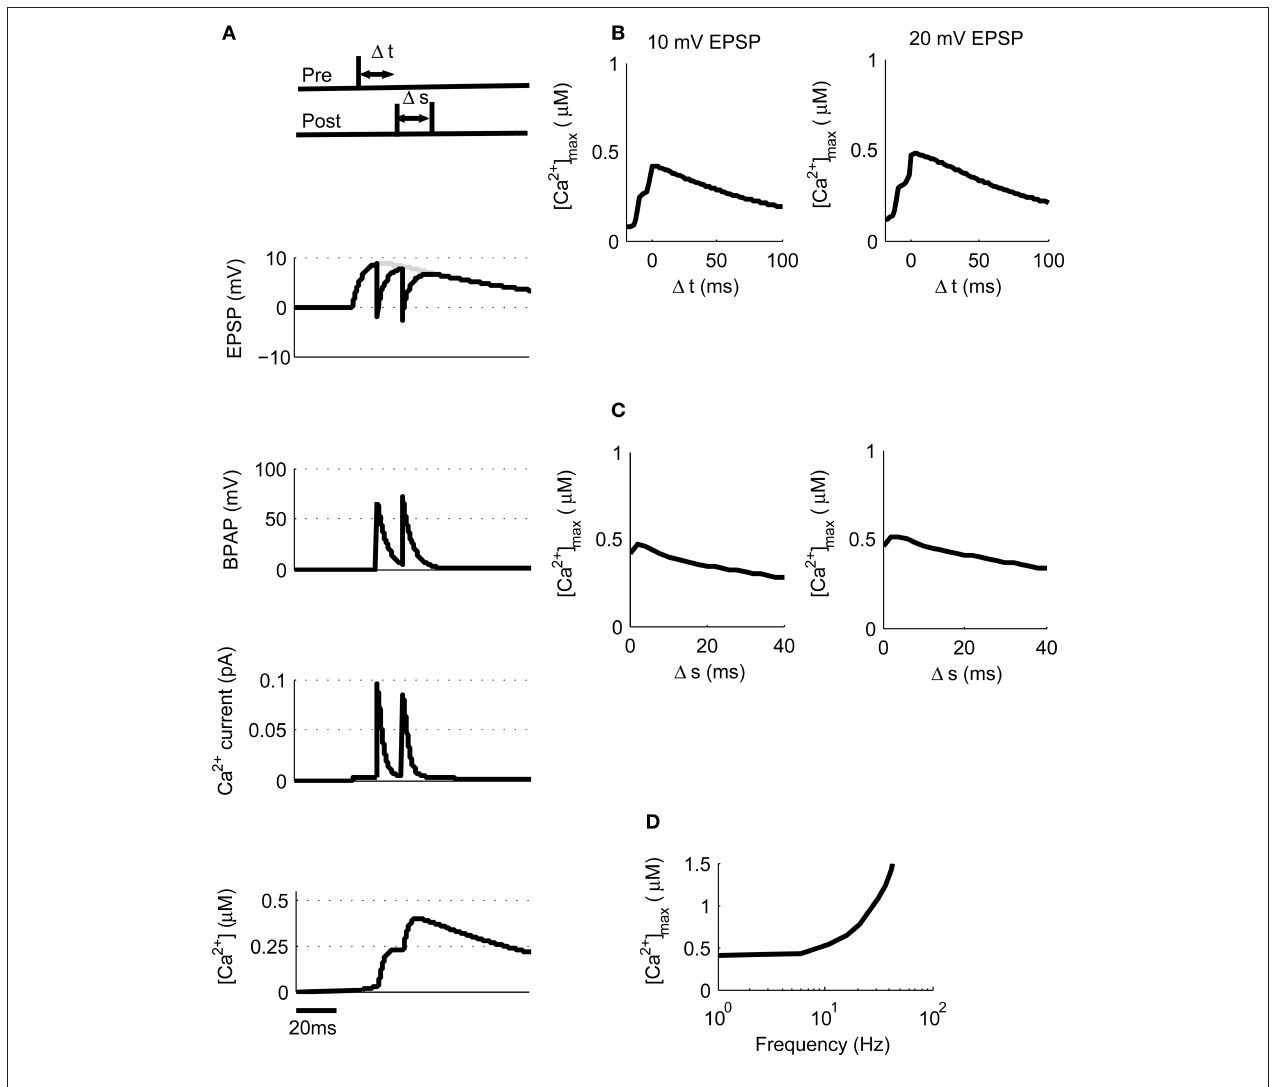
Figure 4 | [Ca 2 + ] dynamics in response to triplets of one pre- and two post-synaptic spikes. (A) The model calculates [Ca 2 + ] within a spine from the membrane potential resulting from a triplet of pre- and post-synaptic spikes. Gray line shows EPSP in the absence of BPAP. (B) . Varying ∆ t shows